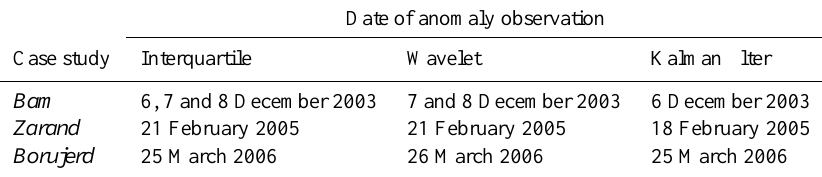
Fig. 12. Same as Fig. 10 but for the Borujerd earthquake (31 March 2006) from 1 March to 15 April 2006. Figure 12. Same as Figure 10 but for the Borujerd earthquake (31 March 2006) from 01 March to 3 Table 2. Detected anomalies for studied earthquakes in LST variations using the interquartile, wavelet and Kalman filter methods. Date of anomaly